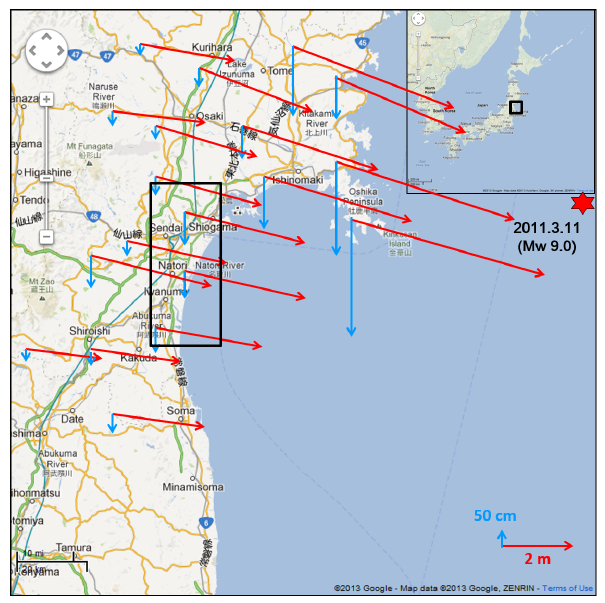
Figure 3. GPS-observed displacement vectors at 18 ground stations in Miyagi Prefecture during the period from 1 March to 1 April 2011 in the horizontal and vertical directions; the black rectangle shows the common target area used in this